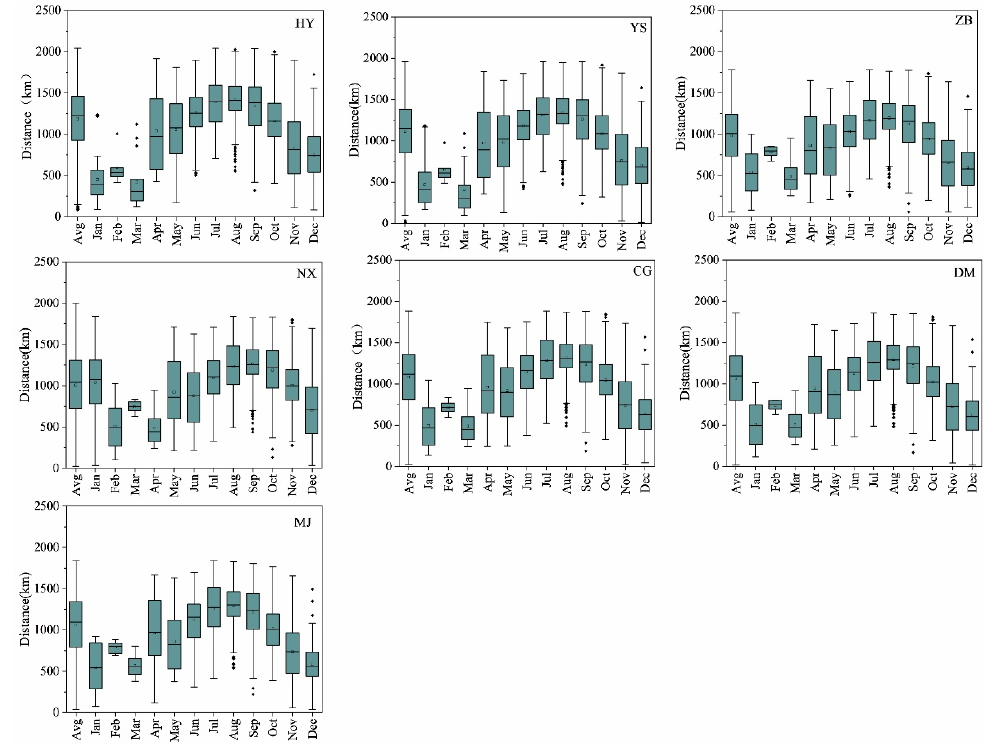
Figure 8. Monthly distribution of radii (distances between tropical cyclone center and island) in the period 2001–2018.